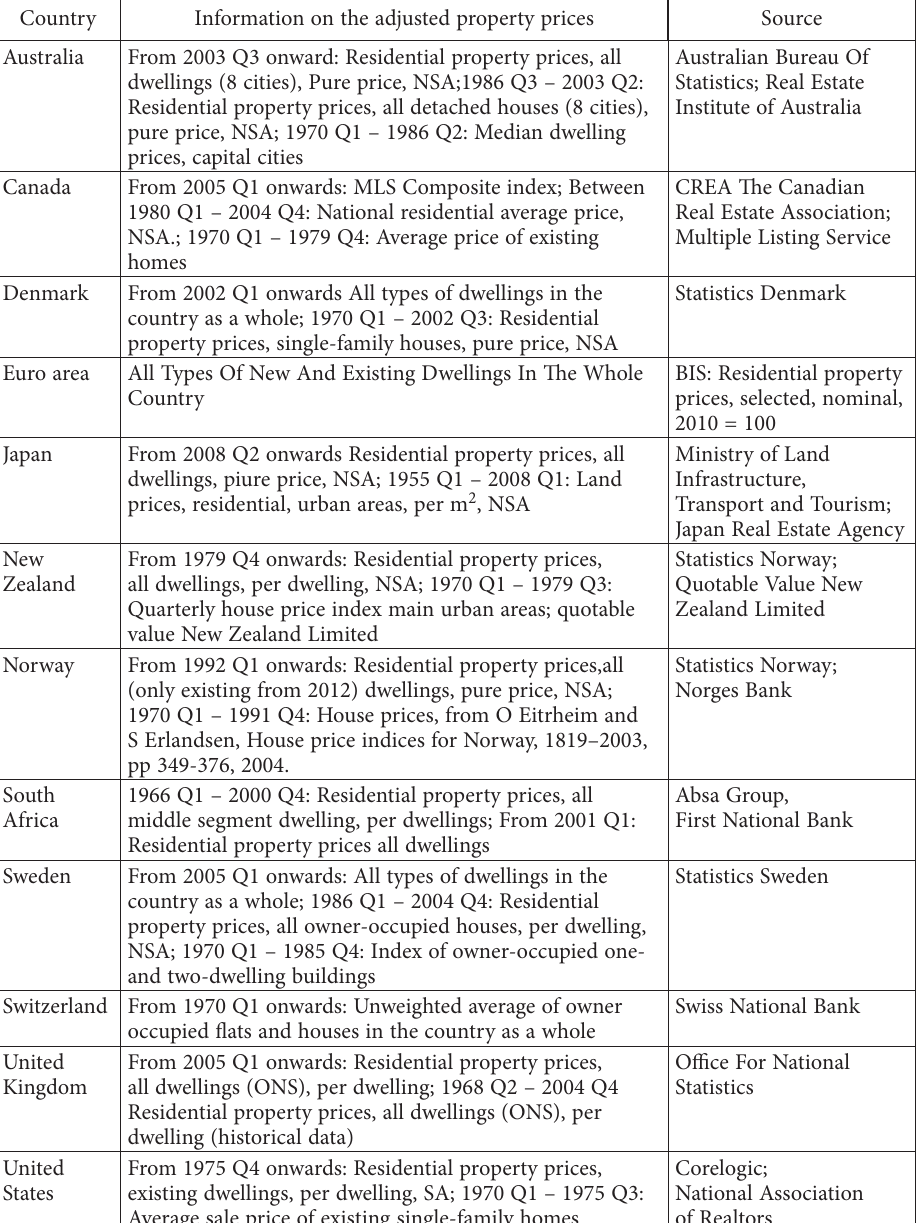
Table 1A. House Price data (source: BIS Residential Property Price database